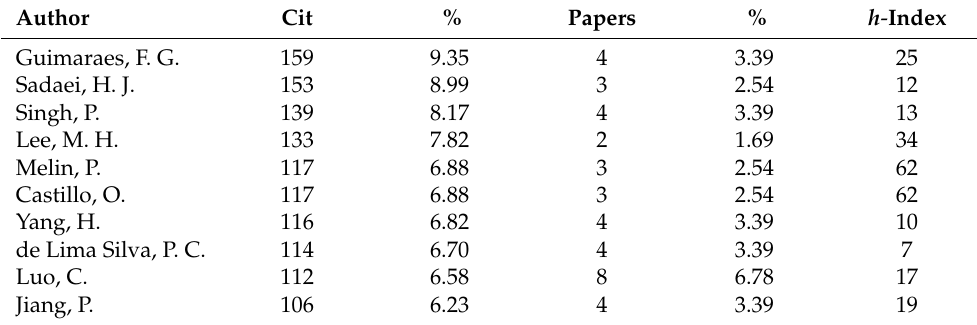
Table 5. Number of citations (Cit) and articles published by the top 10 most cited